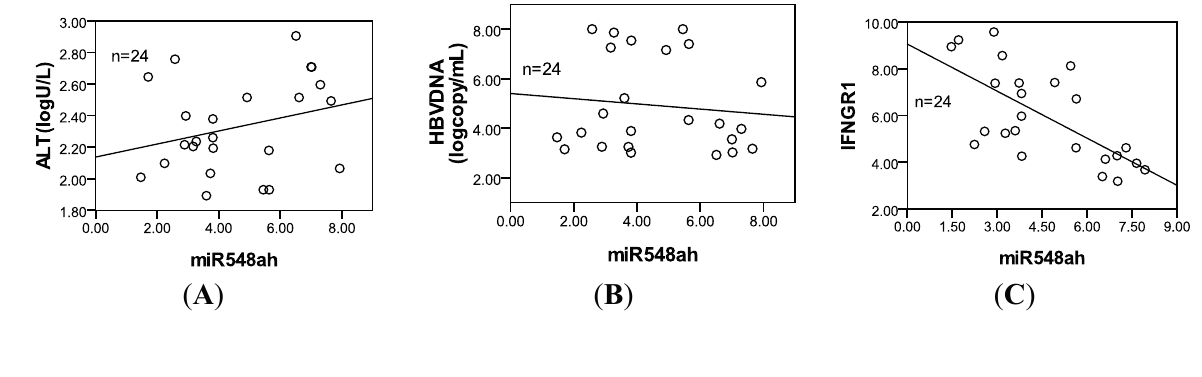
2.5. Correlation of miR-548ah with ALT, HBV DNA and IFN- γ R1 mRNA of Patients with CHB The 24 CHB patients had an ALT level of 2.3 ± 0.3 (logarithm values) and an HBV DNA level of 4.9 ± 1.9 (logarithm values). No significant correlation was found between miR-548ah, ALT, and HBV DNA( r = 0.28, − 0.11, p > 0.05) (Figure 5A,B). The mRNA levels of IFN- γ R1 in IA phase ). Significant negative correlation was found between the levels of of CHB were 5.9 ± 2.0 ( Δ C t miR-548ah and mRNA levels of IFN- γ R1 ( r = − 0.67, p < 0.01) (Figure 5C). ) and three indicators Figure 5. Scatter diagram of correlation between miR548ah ( Δ C t of CHB patients. ( A ) ALT ( r = 0.28, p > 0.05); ( B ) HBVDNA ( r = − 0.11, p > 0.05); ( C ) IFN- γ R1 ( Δ C ) ( r = − 0.67, p < t